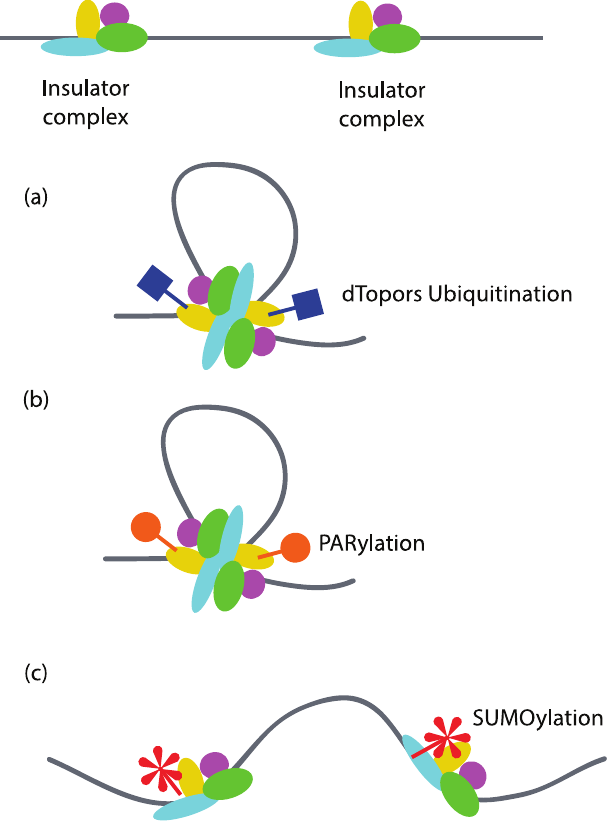
Figure 5. Regulation of insulator activity by covalent modification of insulator factors. insulator-mediated looping interactions. ( a ) Ubiquitination of Su(Hw) by dTopors